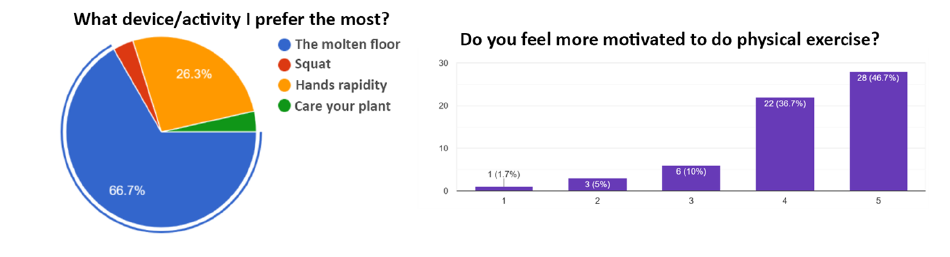
Figure 14. A sample of the user satisfaction